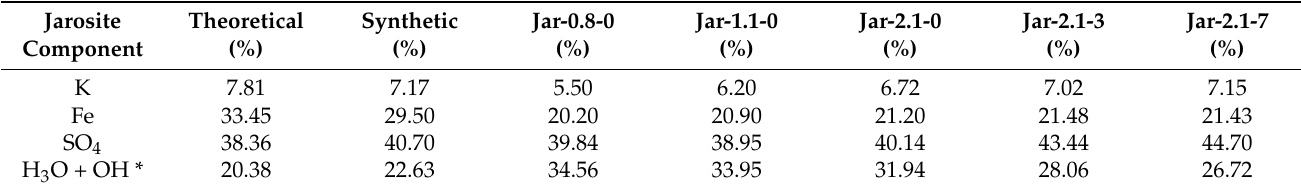
Table 4. Energy dispersive spectrometry (EDS) point analysis of all the synthesized samples as compared with the theoretical and synthesized values reported [32].